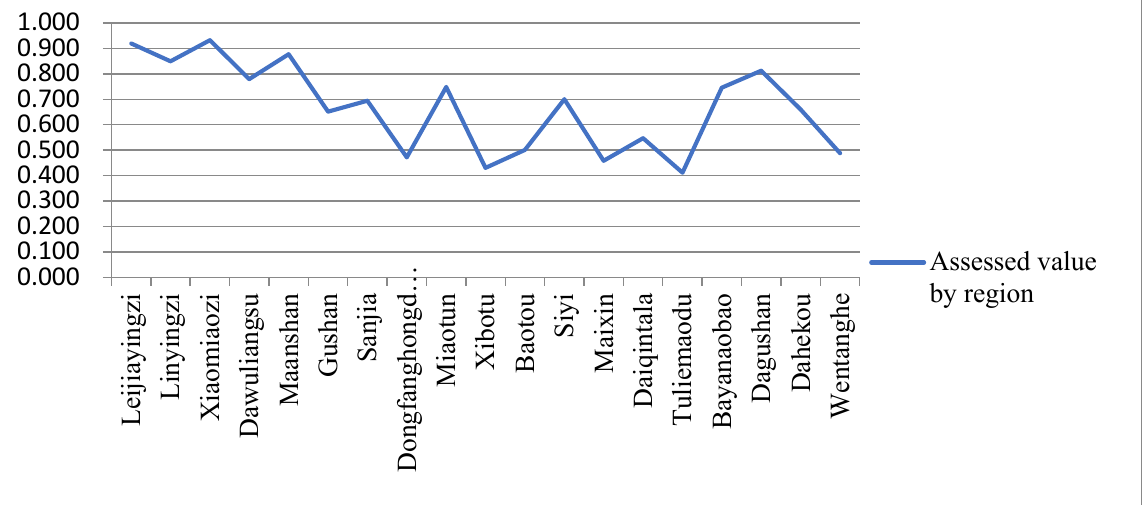
Figure 4. Value assessment of rural preservation and inheritance sub-regions in the Western Liao River Basin, Inner Mongolia, China. Table 4. GML index for assessing the value of rural preservation and inheritance in the Western Liao River Basin, Inner Mongolia, China.